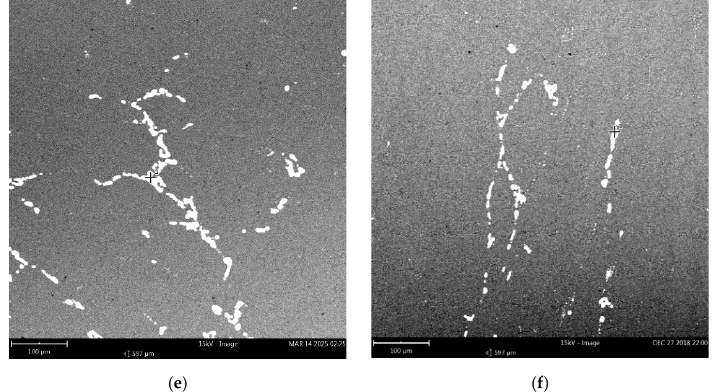
Figure 6. SEM micrographs of the deformed samples under the conditions of: ( a ) 623K–0.1/s–60s–0.36;